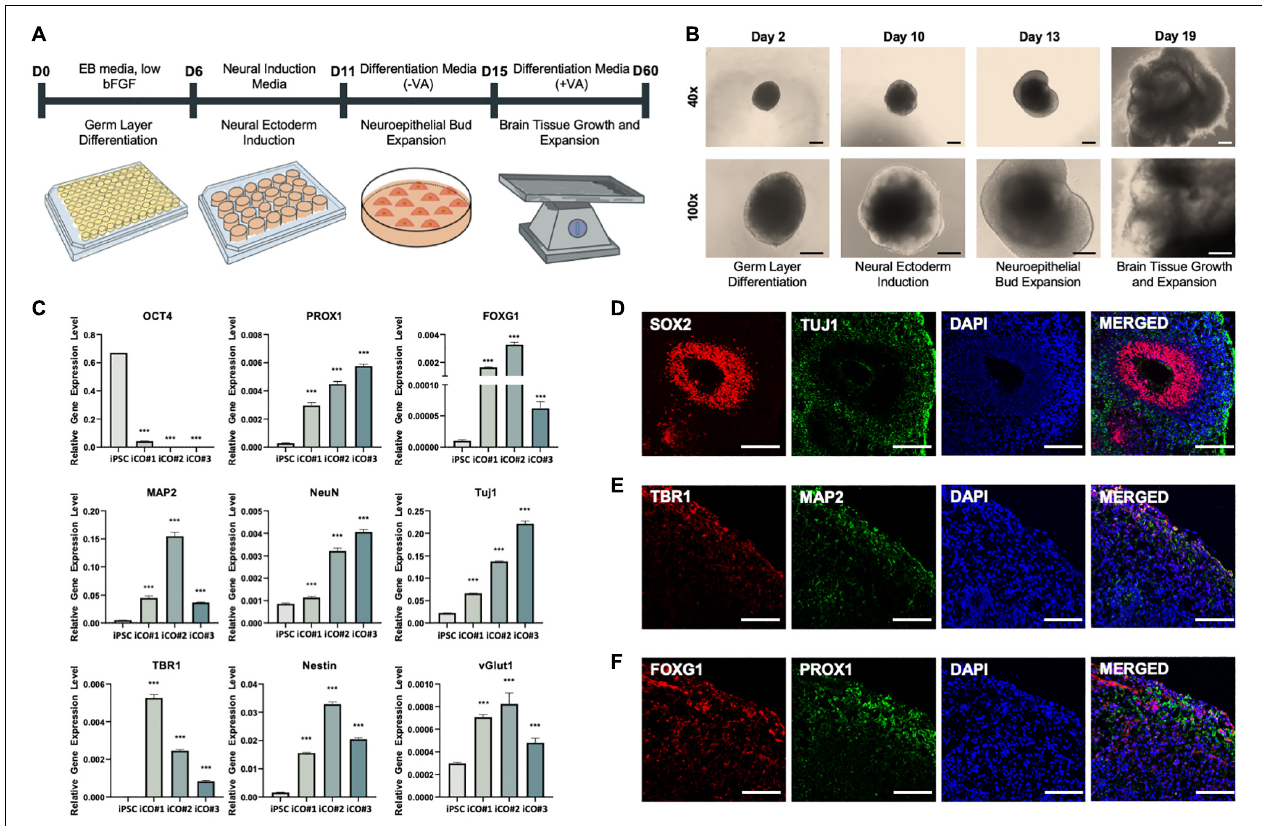
FIGURE 3 | Successful differentiation of cerebral organoids from induced pluripotent stem cells obtained from healthy patient. (A) Differentiation of cerebral organoids derived from induced pluripotent stem cells. (B) Images of cerebral organoids in each step of the experiment. (C) Gene expression normalized to that of GAPDH : pluripotency marker OCT4 , hippocampal marker PROX1 , forebrain marker FOXG1 , neuronal markers MAP2 , NeuN , and TUJ1 , deep-layer neuron marker TBR1 , neural progenitor cell marker Nestin , and glutamate transporter marker vGLUT1 . Immunofluorescence assay showing the co-localization of (D) early-stage neuronal marker SOX2 and neuronal cell-body marker TUJ1, (E) deep-layer neuron marker TBR1 and neuronal dendrite marker MAP2, and (F) forebrain marker FOXG1 and hippocampal marker PROX1, in the cerebral organoids. t -tests were performed for data analysis (*** P < 0.001). Values are presented as mean ± standard error of mean. Scale bars, 200 µ